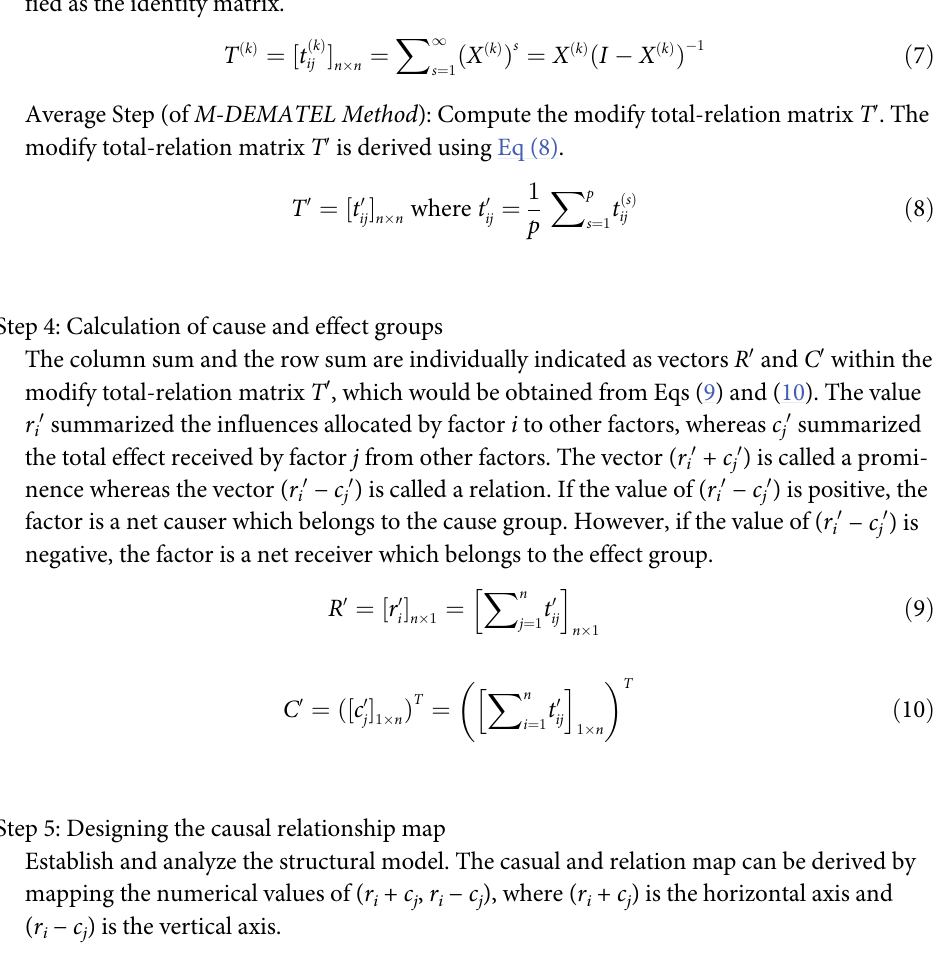
Step 5: Designing the causal relationship